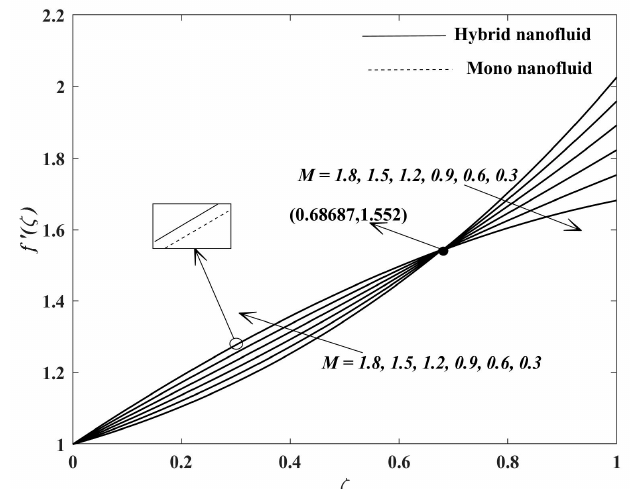
Figure 4. When the values of We x = 0.05, ε = 0.8,Pr = 7, S = − 1 and m = 0.6 are held constant, the velocity profiles exhibit changes as M varies. These variations can have a significant impact on the velocity distribution and provide valuable insights into the behavior of the system. Considering